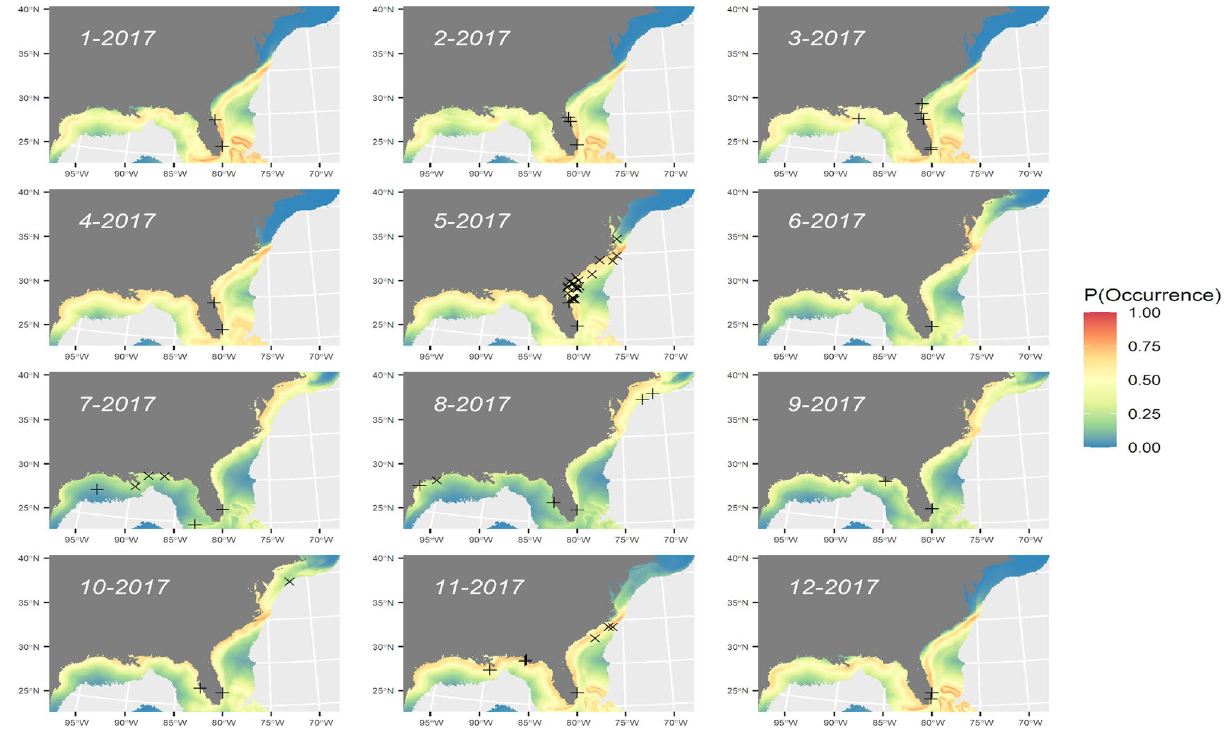
Figure 3. Predicted probability of occurrence for manta rays by SEFSC surveys for monthly average environmental conditions in 2017 with overlay of internal (X) and external (+) validation points. Map generated in R v. 4.1.2 (https:// cran.r- proje ct. org/ bin/ windo ws/ base/).